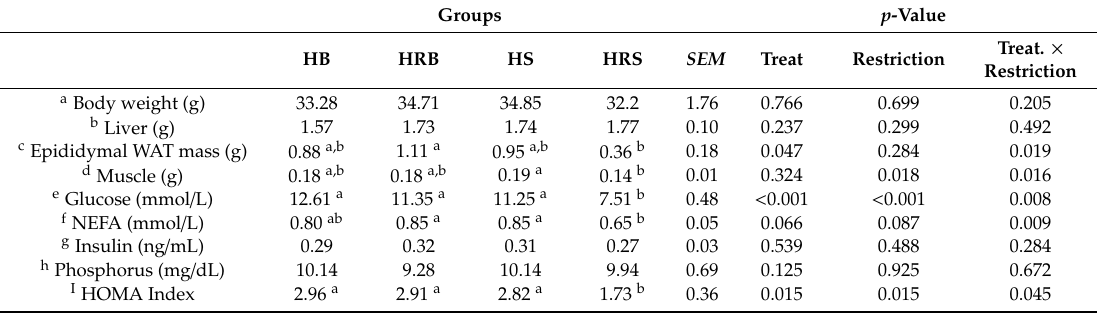
Table 1. Tissue weight and blood biomarkers of mice fed a hypercaloric diet, treated with butaphosphan or saline solution, and submitted or not to food restriction (Experiment